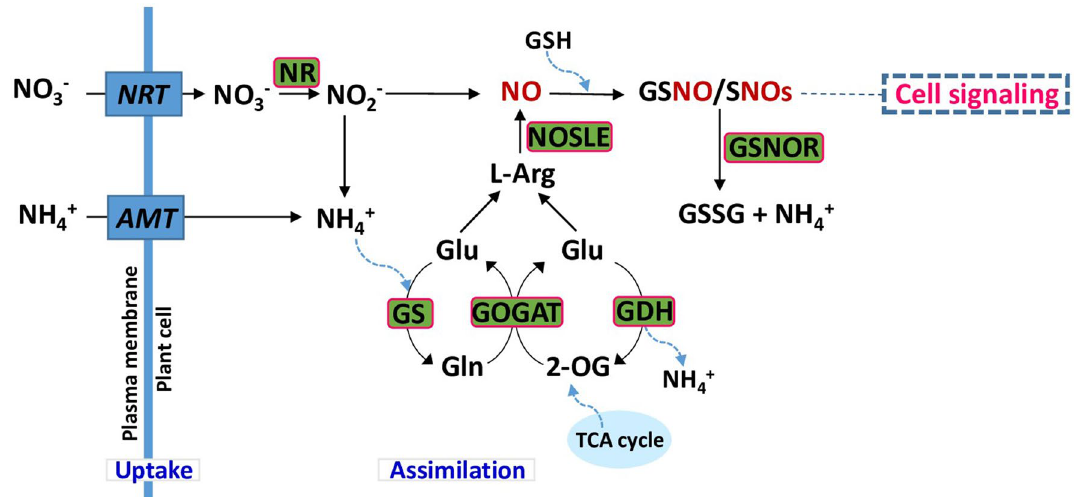
Figure 1. Nitrogen uptake and assimilation, and its interconnection with nitric oxide signaling process in and metabolic status including inhibition of mineral nutrient uptake, allocation and assimilation. Among various nutrients, nitrogen (N) is a key nutrient for plant growth and development as a building block of fundamental biological molecules, such as nucleotides, amino acids, proteins, ATP, co-enzymes and chlorophyll 13 . In fact, N